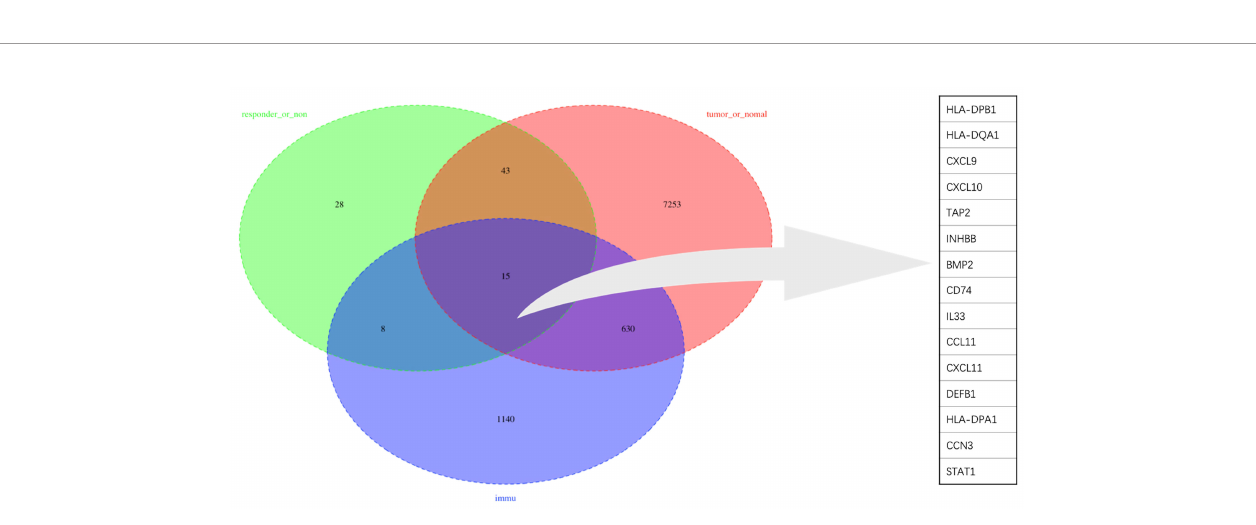
FIGURE 4 | Venn diagram of the overlapped genes between DEGs and